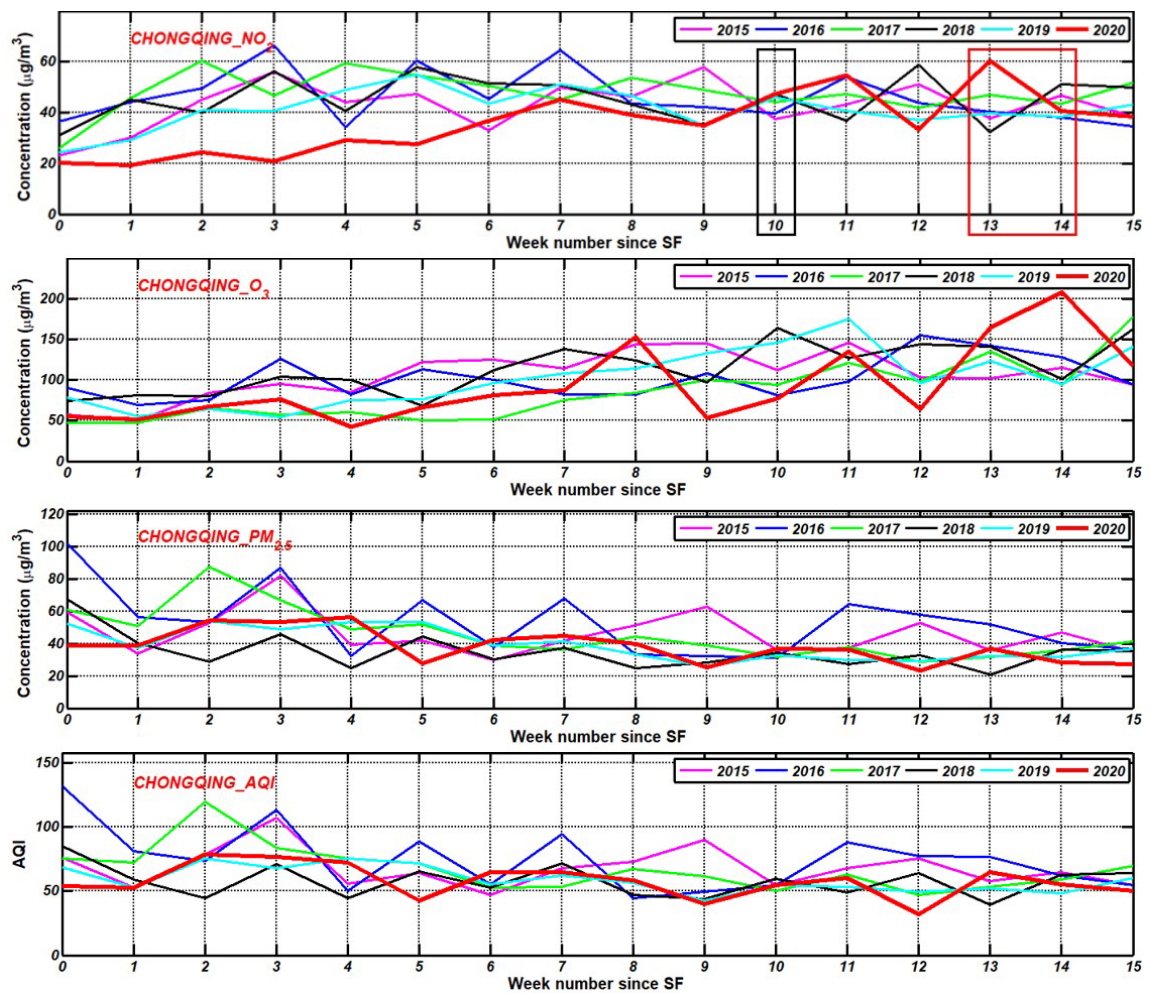
Figure 8. As Fig. 6 but for